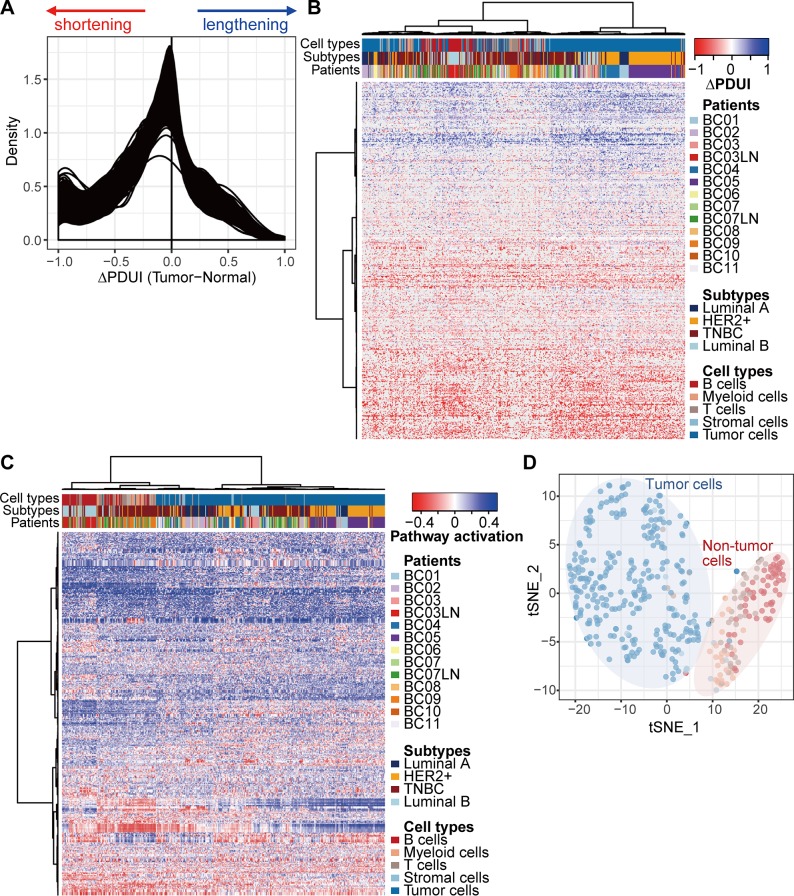
Different APA patterns between tumor and non-tumor cells.(A) The signals of APA (ΔPDUI calculated by DaPars) for all genes were shifted toward 3’UTR shortening in 515 single cells derived from 11 breast cancer patients (BC01-11). We followed the labels for the patients and cell types pre-defined to original datasets [14]. BC; Breast cancer, LN; Lymph nodes. Hierarchical clustering was performed using APA estimates (B) for genes and (C) gene sets on individual cells derived from breast cancer patients. Only 419 cells with at least 542 (10% of total genes) detected genes were selected for further analysis. A total of 1,452 genes and 3,353 gene sets showed the signals of APA on 419 cells. Among theme, 453 genes and 555 gene sets were selected as variable components for hierarchical clustering and dimensional reduction, respectively (see Methods). (D) Unsupervised tSNE on the gene set-level APAs separating 280 tumor and 139 non-tumor cells (immune and stromal cells) in breast cancer. Individual cells are colored for samples, consistent with the coloring in Fig 1B and 1C.